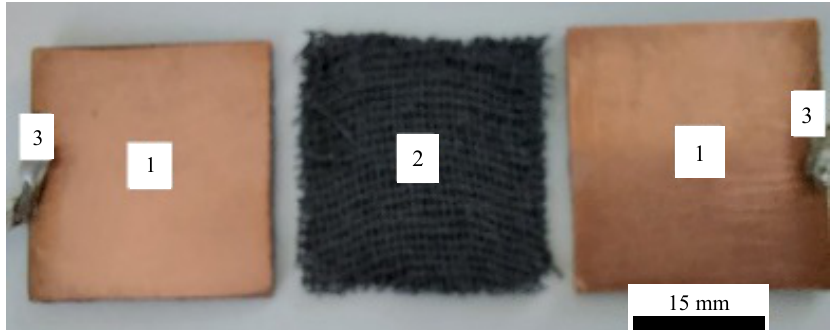
Figure 6. The components of the electrical device: 1—copper coated side of plates, 2—magnetizable CMs, 3—electrical connectors. The image was taken under different illumination conditions than those used for the image in Figure